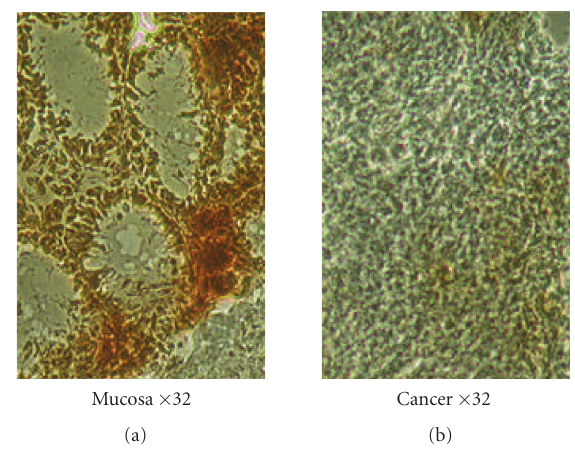
Figure 2: Apoptosis evaluated in mucosa and colon cancer by TUNEL